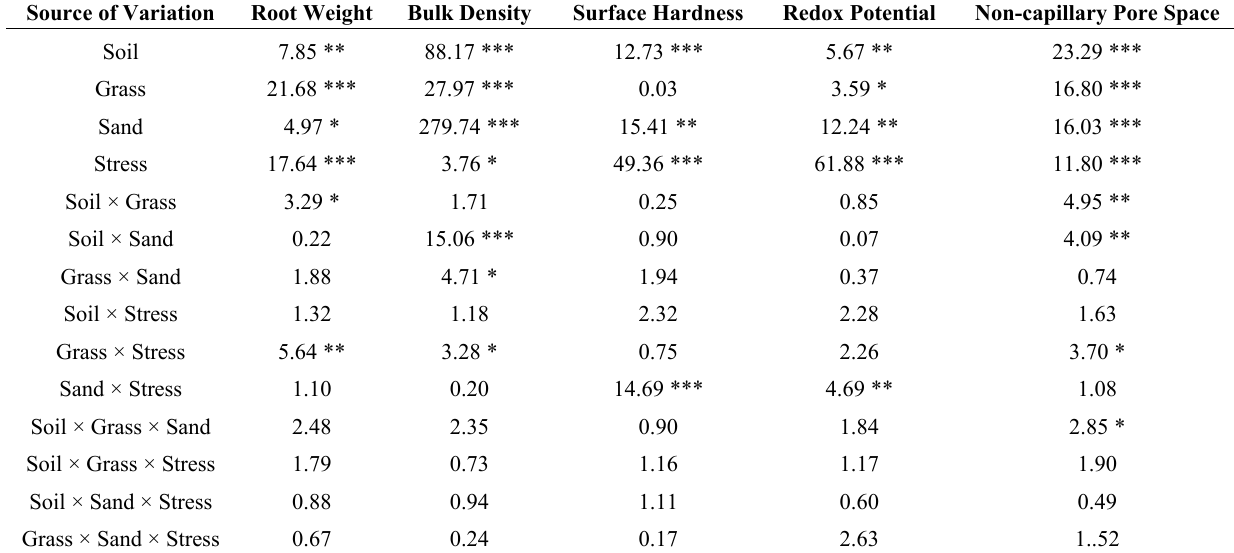
Table 2. Variance ratios for root zone media variables affected by treatments and their